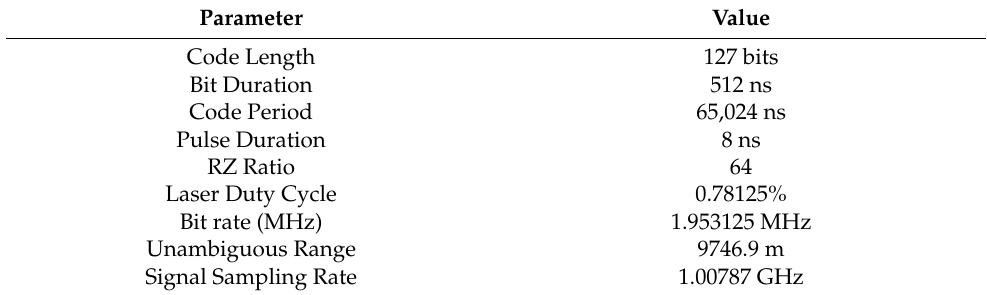
Table 1. SALi PN code